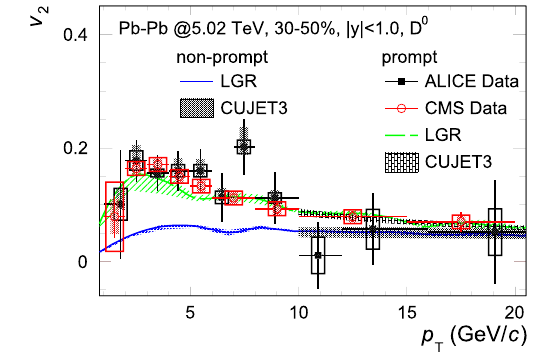
Fig. 7 Same as Fig. 5 (panel-c) but for v 2 . The measured v 2 is taken from ALICE (black square [60]) and CMS measurements (open red circle [61])